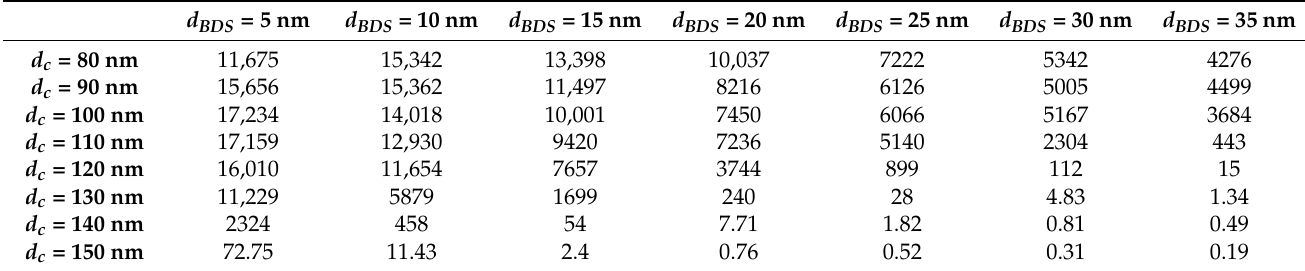
Table 1. Comparison of the sensitivity S R ( /RIU ) with different thickness of d BDS and d TiO2 .